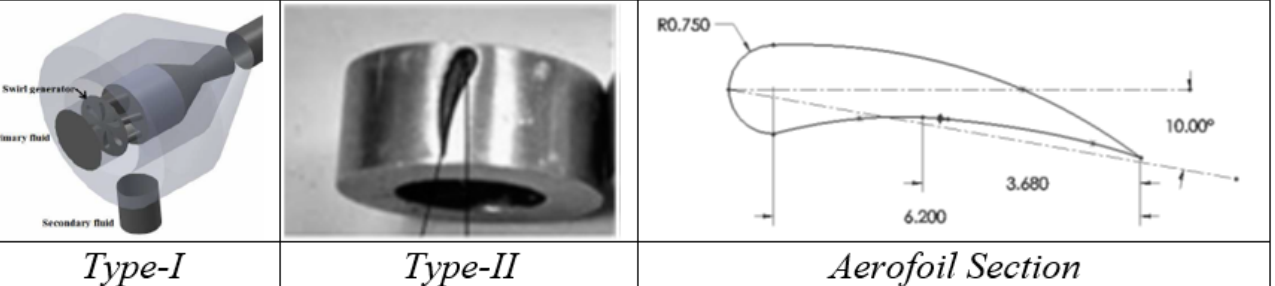
Figure 15. Swirl generator of Banu et al. [69,70].